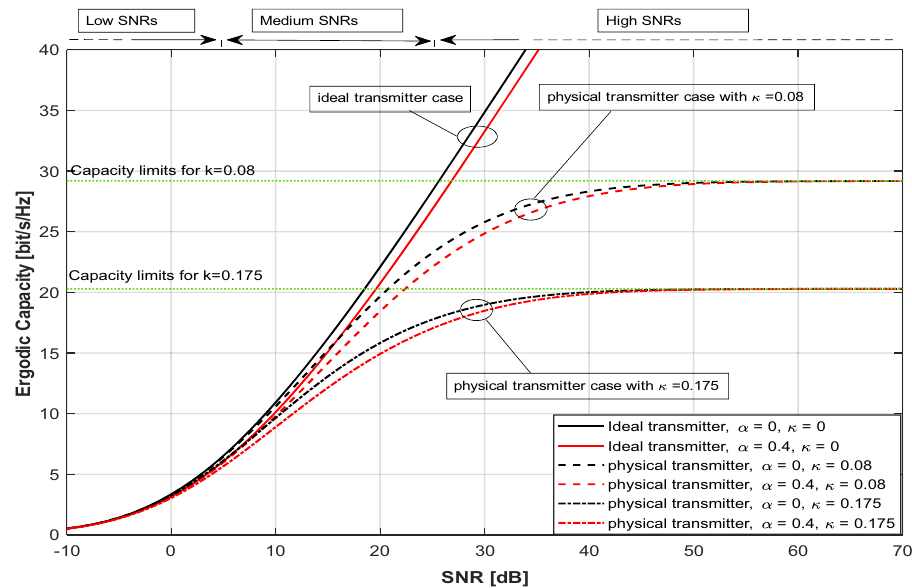
Figure 2: Ergodic capacity of the 4 4 × MIMO channel with di ff erent levels of impairments κ 0, 0.08, 0.175 {